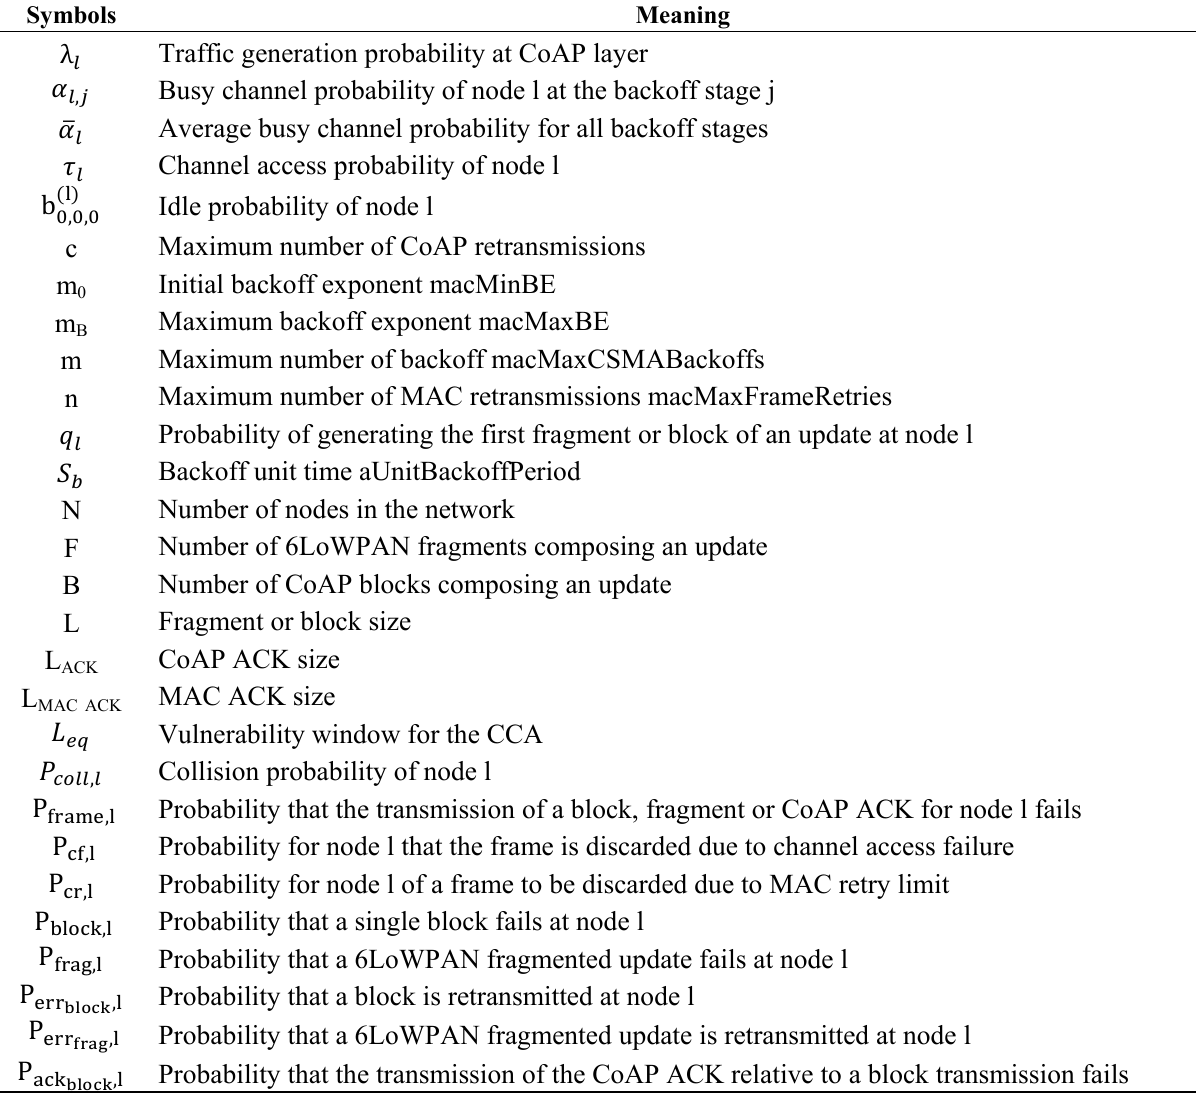
Table 1. Main symbols used in this